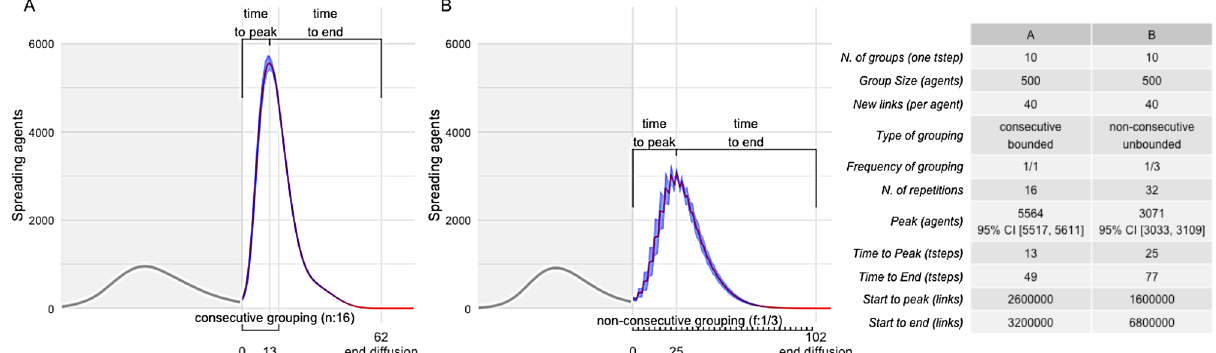
Figure 2. In panels ( A ) and ( B ), characteristic features used in reporting the results are showed. The peak of the process represents the maximum number of Infected. The peak time step is indicated on the x axis with the offset from the origin [+ 13 in panel ( A ) and + 25 in panel ( B )]. Time to peak and time to end represent duration (in time steps). Asymmetry of the curve and dependence on different factors makes it useful to measure the two parts independently. Start of grouping and end of diffusion are typical points in the timeline, respectively, indicated with 0, corresponding to the flex of the curve and the first time step of dynamic grouping, and a point that varies for each configuration, by convention assumed as the time step when the majority of trials has no Infected agent left [indicated as an offset from the flex, + 62 in panel A and + 102 in panel ( B )]. Grouping pattern and duration are indicated with horizontal brackets. For panel ( A ), grouping has been repeated for 16 consecutive time steps; for panel ( B ), grouping has a 1/3 frequency and run from start to end of diffusion. In both cases, we see that the peak of the dynamics, while depending on grouping, may occur before grouping ends. The table lists the parameters that describe each configuration. We will use the notation #G for the